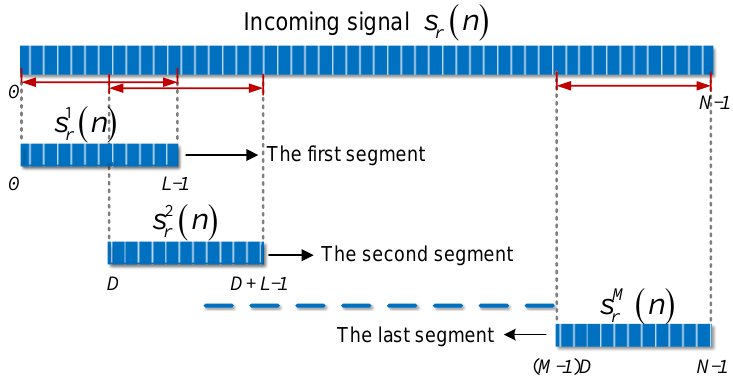
Figure 2. Explanation of segmentation for the proposed method. The entire signal falls into M segments.